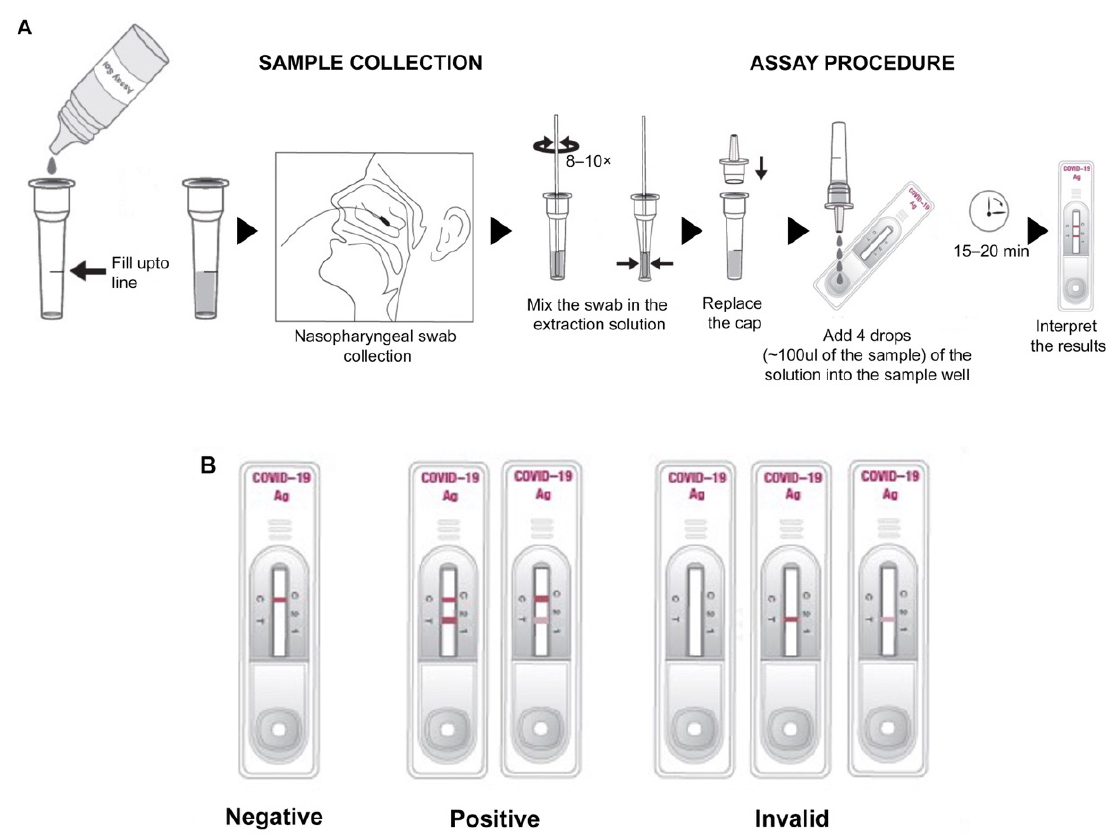
Figure 2. Schematic representation of ( A ) sample collection and assay procedure, ( B ) interpretation of test results of the RDT strip.